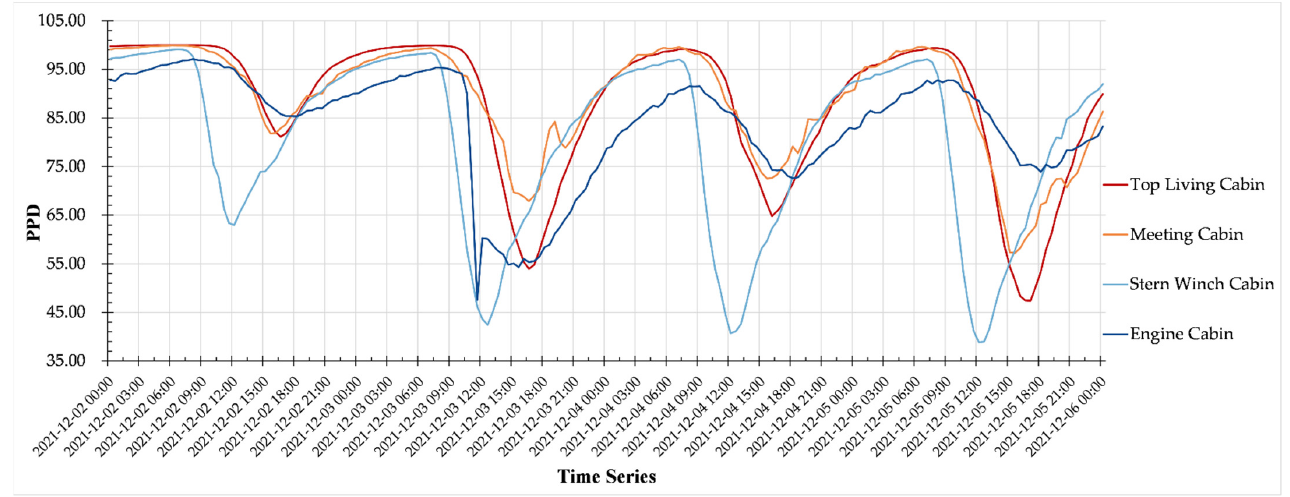
Figure 18. Predicted percentage dissatisfied in the ship between 2 and 5 December 2021.